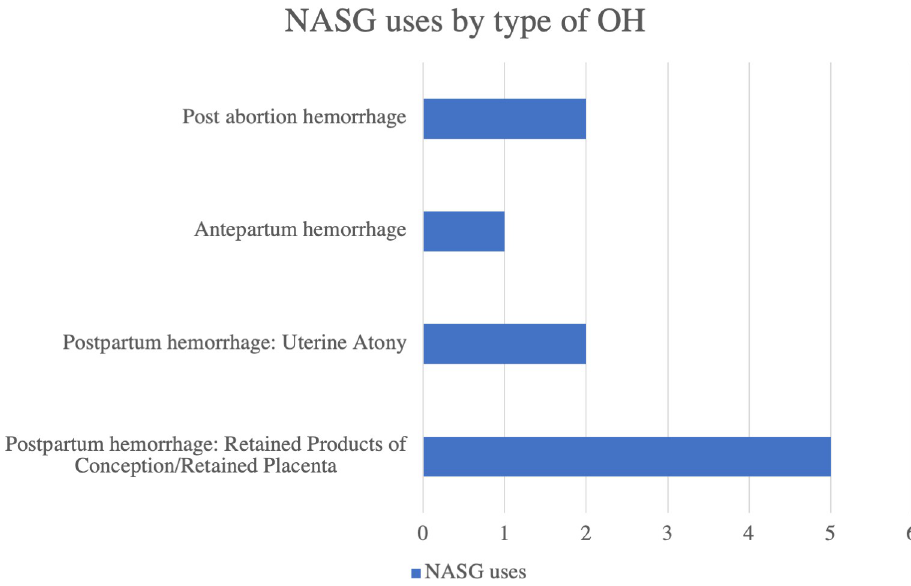
Fig 2. Number of NASG uses by cause of obstetric hemorrhage.